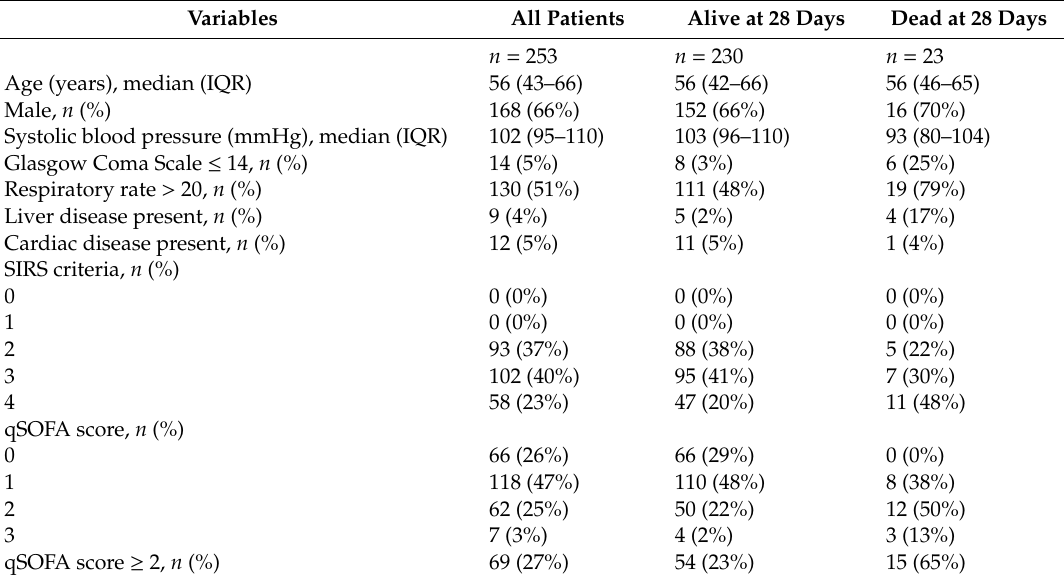
Table 1. Patient Table 1. Patient characteristics.